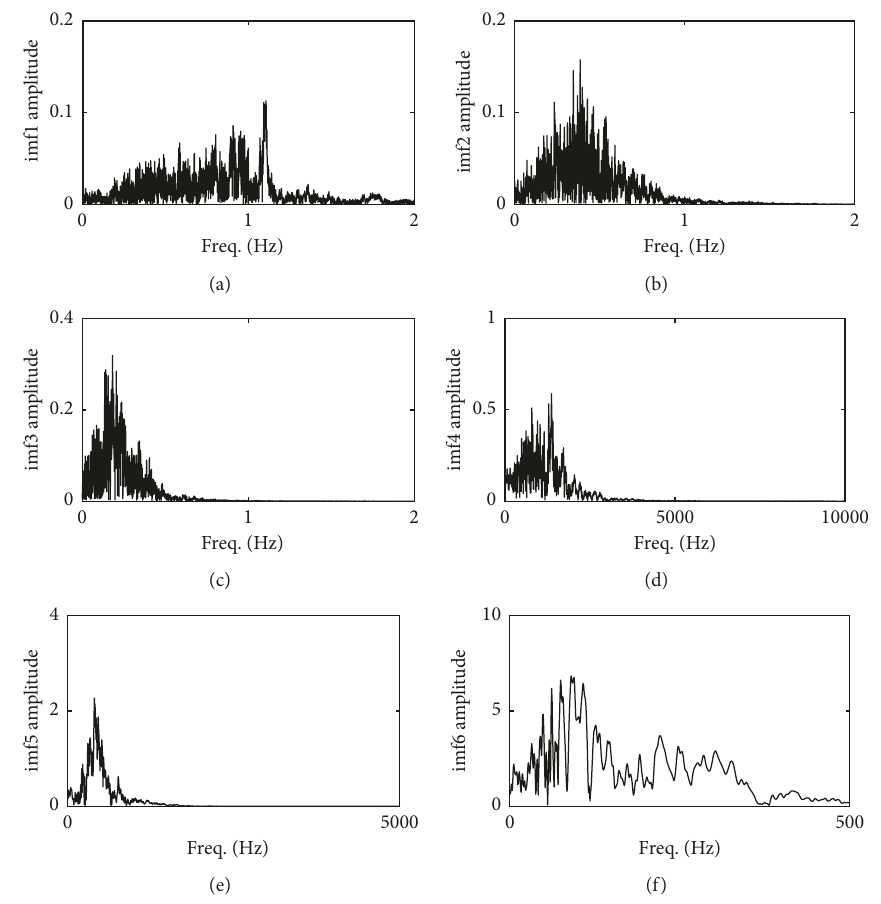
Figure 3: IMF component spectrum of the first 6 orders of sample S 1. Table 4: Frequency band of complex analytic wavelet analysis. Bark z